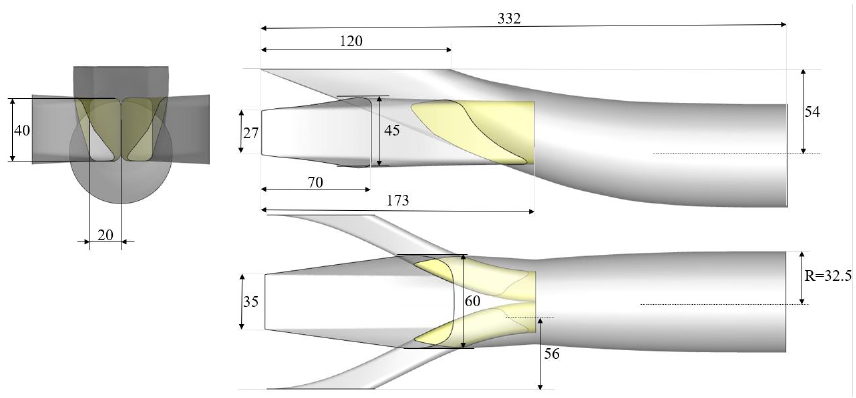
Figure 2. Three views and main parameters of the distributed submerged inlet.